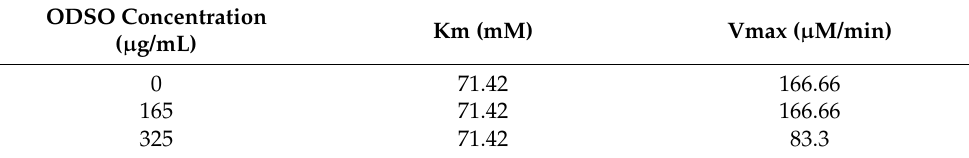
Table 1. Kinetics parameters of α -glucosidase inhibition by Opuntia dillenii seed oil (ODSO).